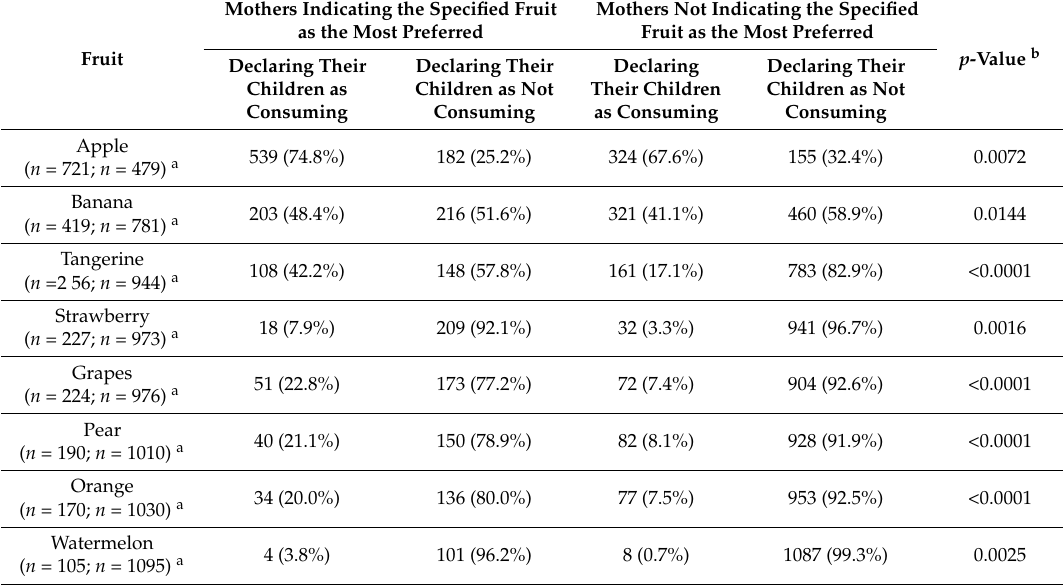
Table 5. Analysis of the association between the fruit preferences of mothers and their declared fruit consumption behaviors of their children in a national sample of Polish respondents ( n =